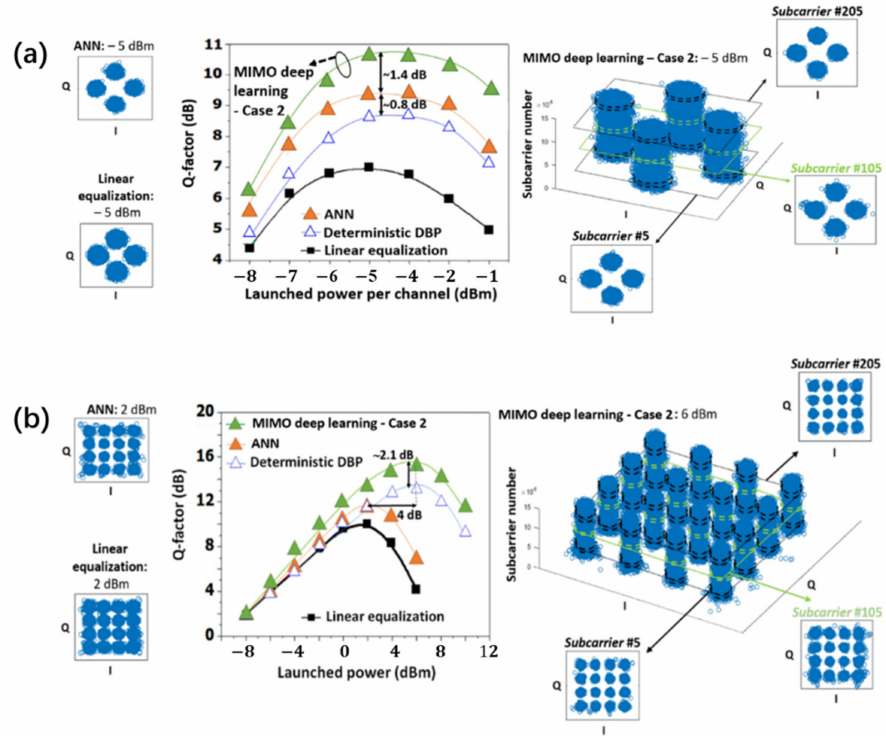
Figure 28. Transmission performance comparison among MIMO deep leaning, ANN and deter- ministic DBP. ( a ) WDM QPSK CO-OFDM at 3200 km; ( b ) single-channel 16-QAM CO-OFDM at 2000